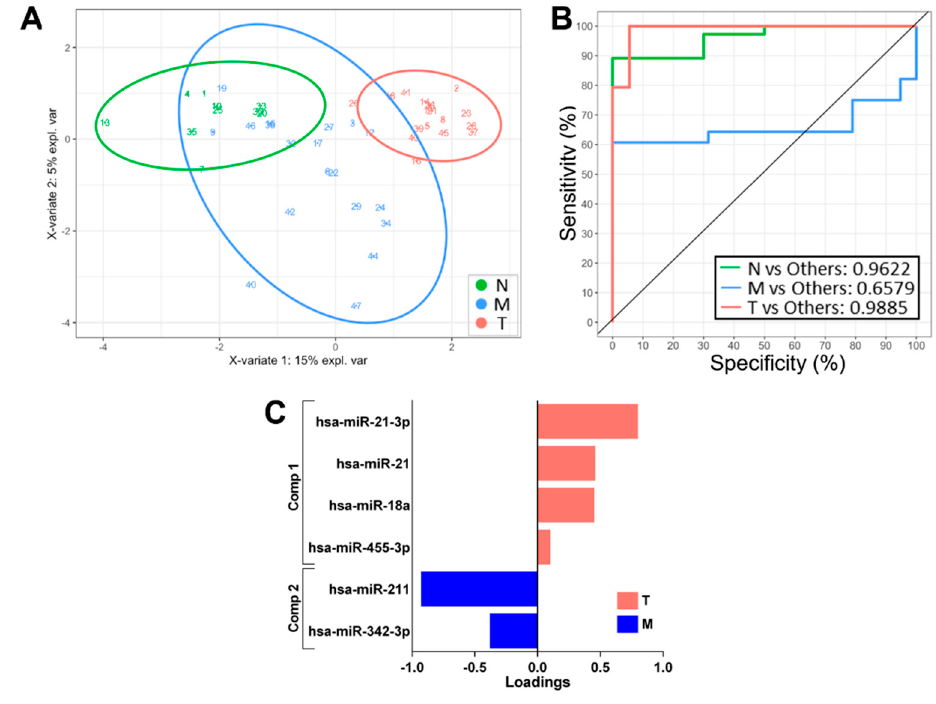
Figure 3. Classification performance of a sPLS-DA-derived miRNA expression signature. ( A ) Two- dimensional sample plots for the 3 groups with confidence ellipse plots. ( B ) Corresponding ROC curve. ( C ) Loading plots for multinomial N vs. M vs. T classifiers showing the contribution of each miRNA to the signature.